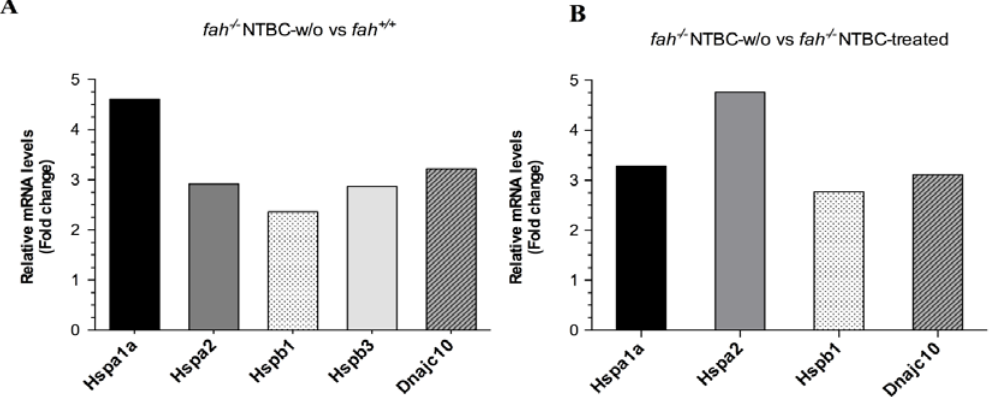
Figure 4. HSPs genetic expression. Influence of HT1 stress on expression levels of transcripts codifying for HSP70 family ( Hspa1a , Hspa2 ), HSPB family ( Hspb1 , Hspb3 ) and DNAJ co-chaperone family. Graphics showing the relative expression level in livers after withdrawal of NTBC in fah −/− mice compared to livers of wild type ( A ), and of fah −/− NTBC-treated mice ( B ). Data are given as mean of two experiments ( n = 2) in a single scan. Each sample is representative of a pool of four different mice for each condition. For all up-regulated genes p < 0.05 was obtained by variance analysis (ANOVA). The tumoral fractions showed an up regulation in the HSPs families up to 5-fold higher compared to the fah +/+ ( A ) and fah −/− control ( B )